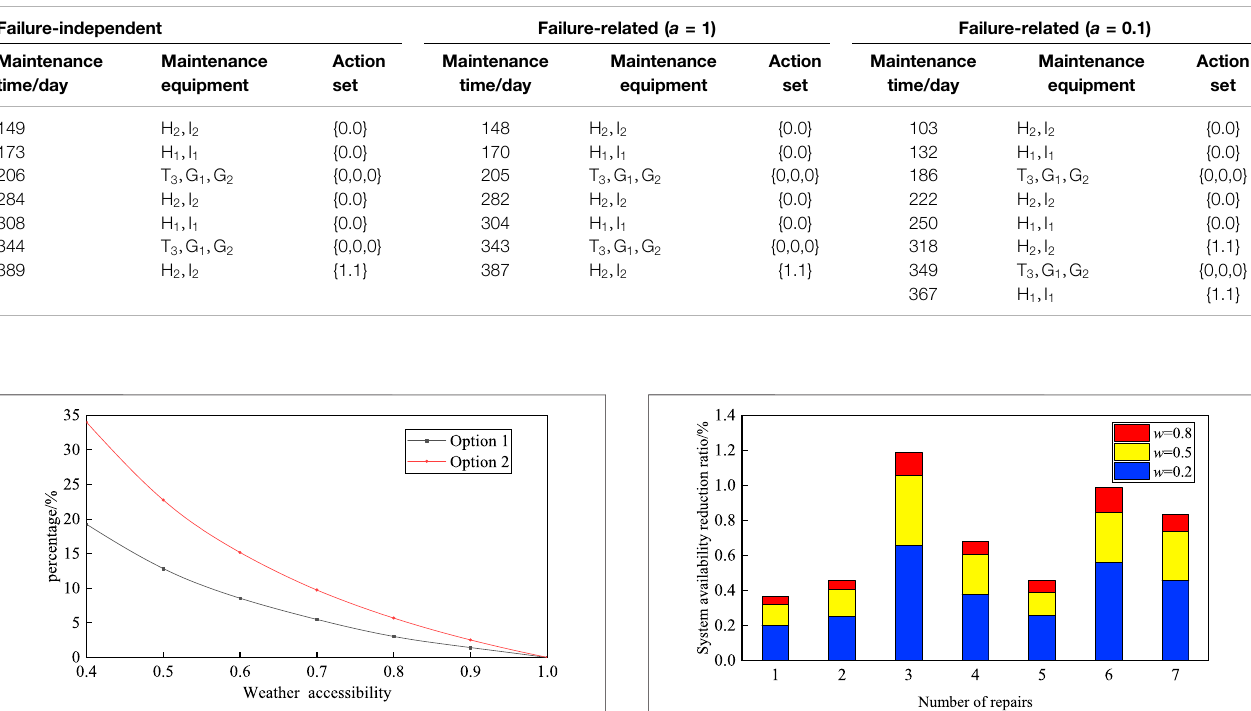
TABLE 5 | Maintenance decision set.